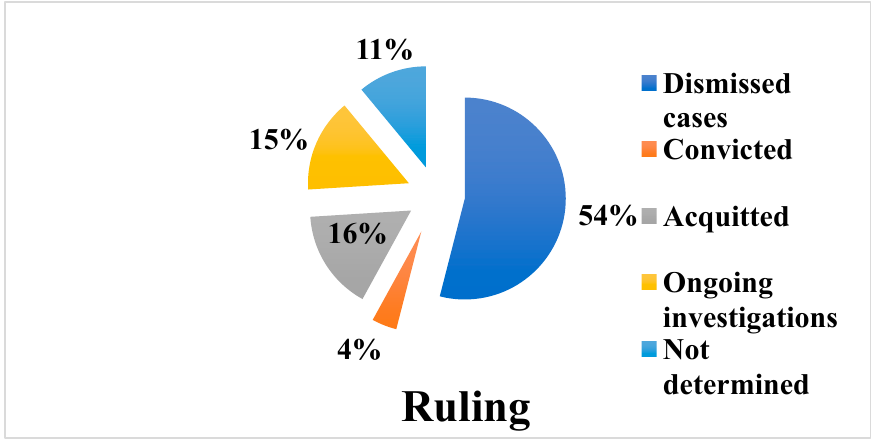
Figure 5. Graph showing rulings on proceedings.